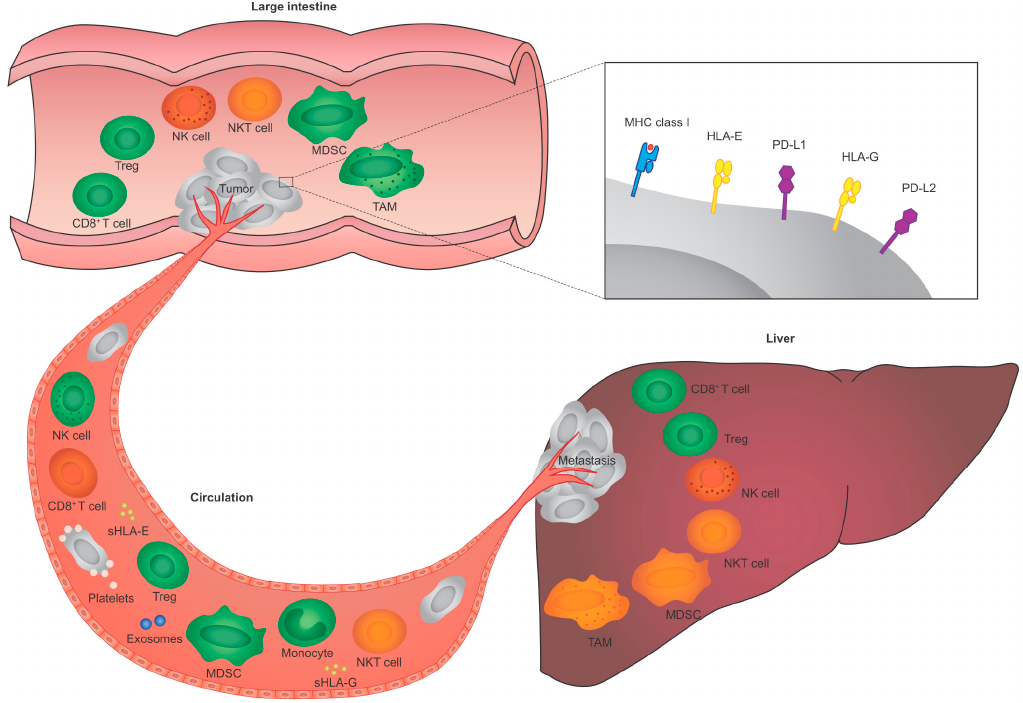
Figure 2. Schematic representation of tumor-immune system interactions in the primary tumor, in the circulation, and in liver metastasis of CRC. Interactions between various types of immune cells and tumor cells take place in CRC, which are immunologically different in primary tumors ( upper part), in the circulation ( left part), and in liver metastases ( right part). In each of these compartments, immune cell types can either affect tumor development (colored in green), have no effect on tumor development (colored in red), or their effect on tumor development is not yet clear in CRC (colored in orange). Abbreviations: CRC, colorectal cancer; HLA, human leukocyte antigen; MDSC, myeloid-derived suppressor cell; MHC, major histocompatibility complex; NK, natural killer; NKT, natural killer T; PD-L1, programmed death-ligand 1; PD-L2, programmed death-ligand 2; sHLA, soluble HLA; TAM, tumor-associated macrophage; Treg, regulatory T cell.